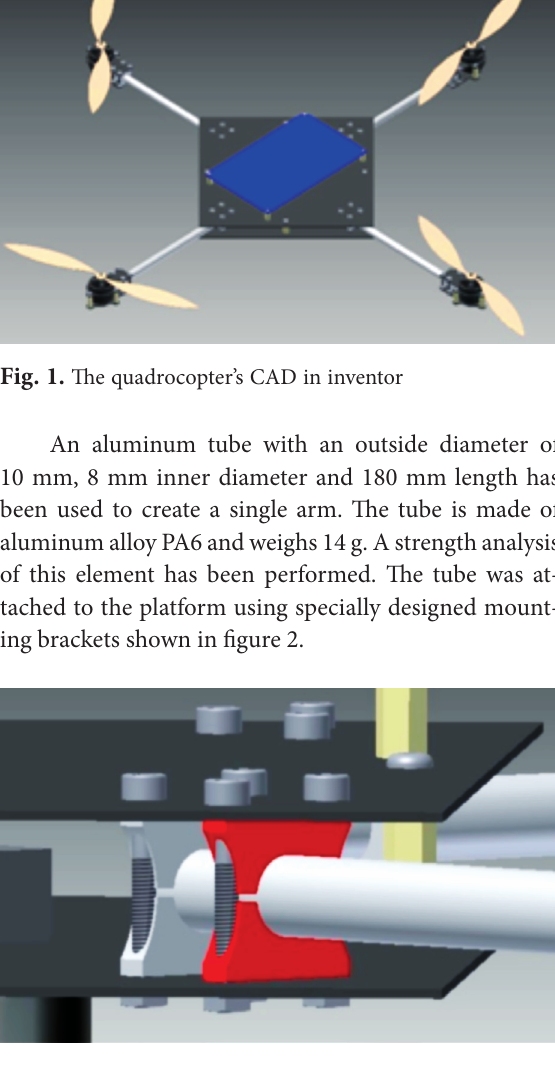
Fig. 2. The brackets fixing the arm to the quadrocopter’s